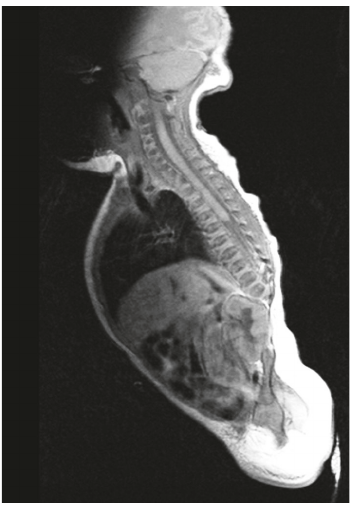
Figure 2: Sagittal T2W MRI of the spine shows severe caudal regression with complete absence of the lumbar spine and sacrum. The conus medullaris has a characteristic, abnormal, wedge-shaped (blunted)